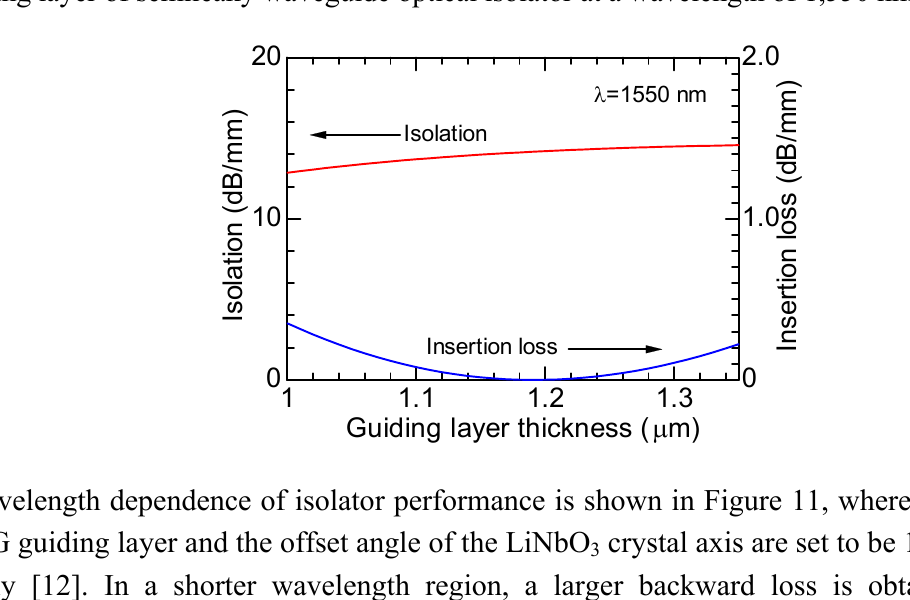
Figure 10. Calculated dependence of isolation and insertion loss on the thickness of Ce:YIG guiding layer of semileaky waveguide optical isolator at a wavelength of 1,550 nm [12].